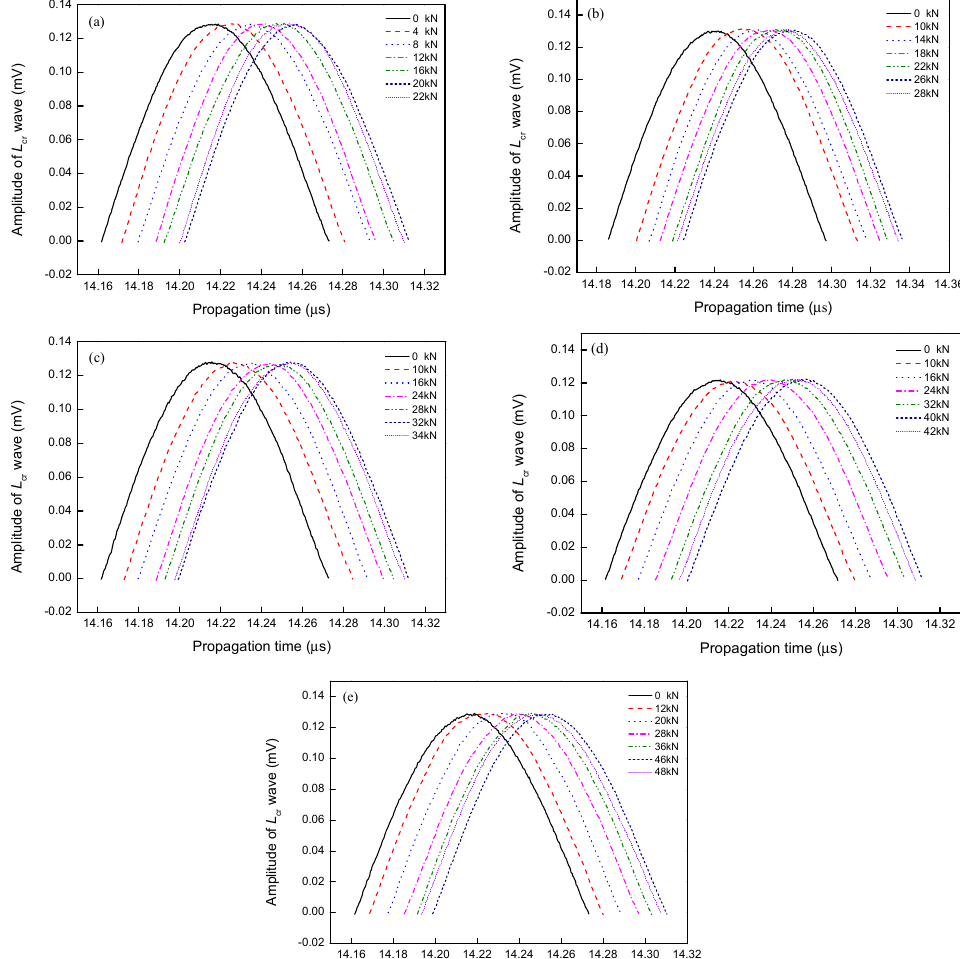
Figure 3. L cr wave of coating with different burial rectangular slots ( a ) 2.0, ( b ) 2.5, ( c ) 3.0, ( d ) 3.5, ( e ) 4.0 mm.